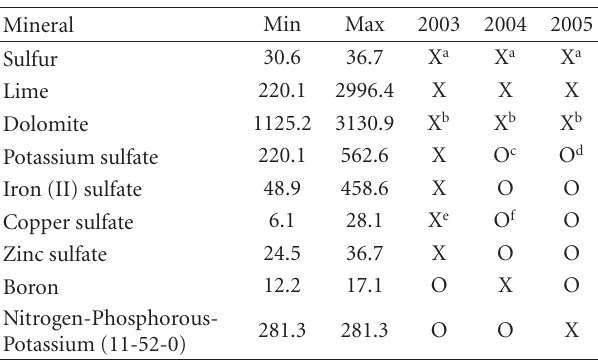
∗ ppm: parts per million or mg/Kg. Table 3: Summary of spring-season soil fertilization application rates (Kg/Ha) at the seven study sites (X: application; O: no appli- cation). Foliage was sampled for phytochemical analyses in fall